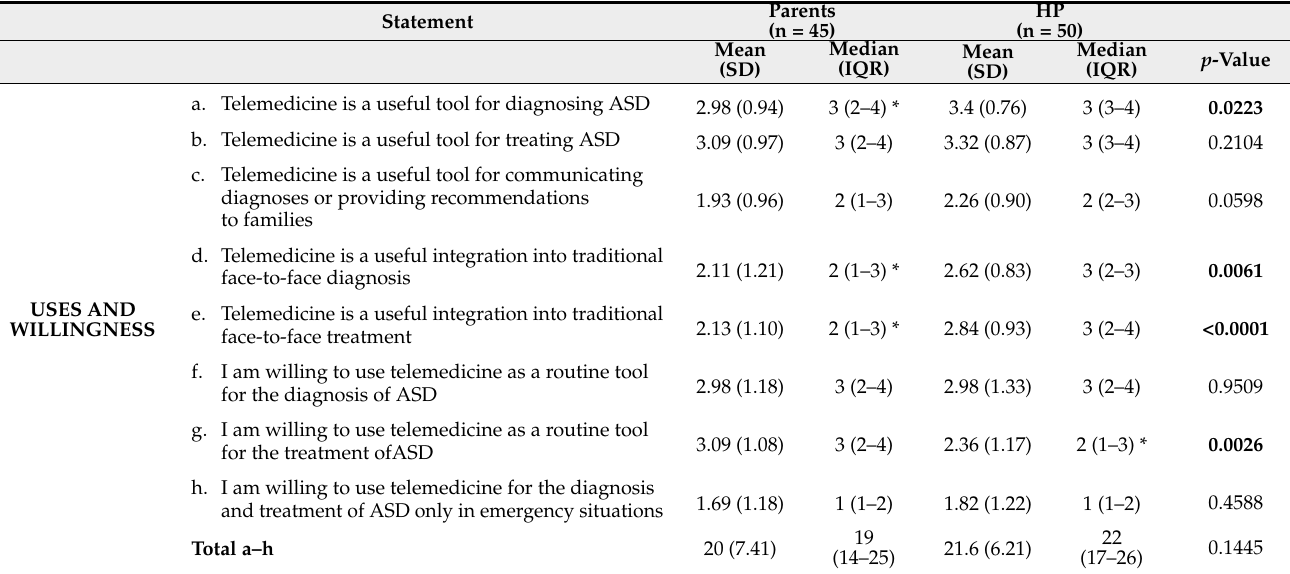
Table 2. Results of Wilcoxon Rank Sum Test for the comparison of parents’ and professionals’ answers on the first section of Telemedicine Expectations Questionnaire: expectations on the uses and potential benefits of